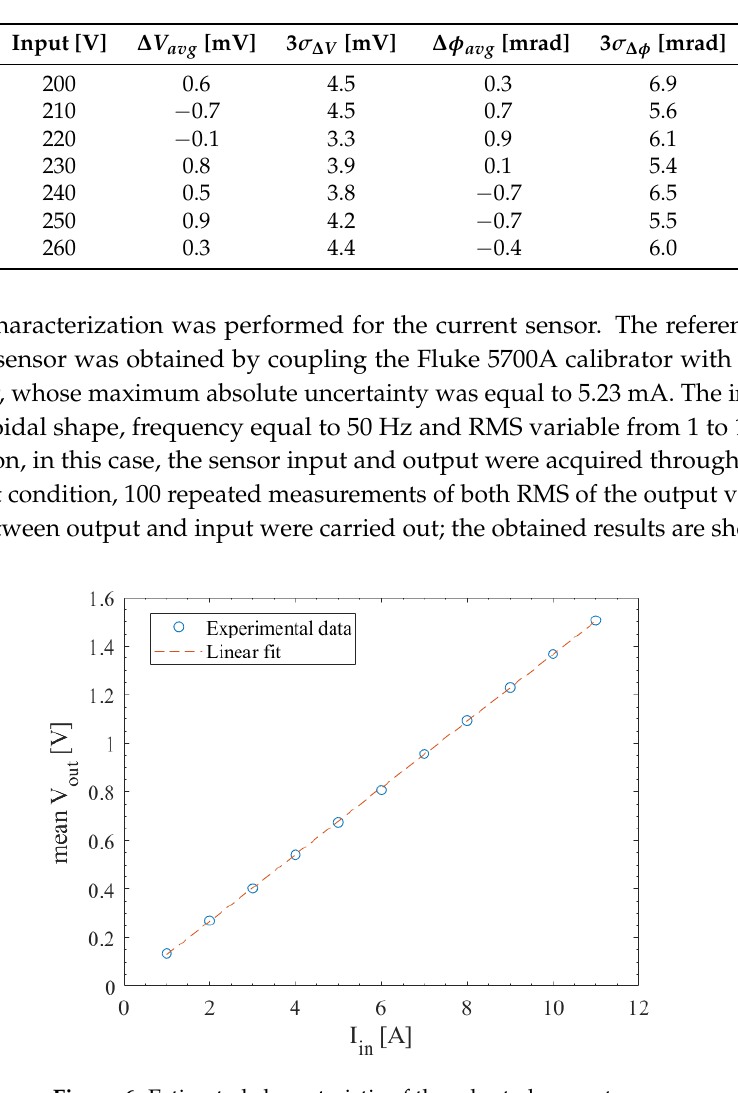
Figure 6. Estimated characteristic of the adopted current